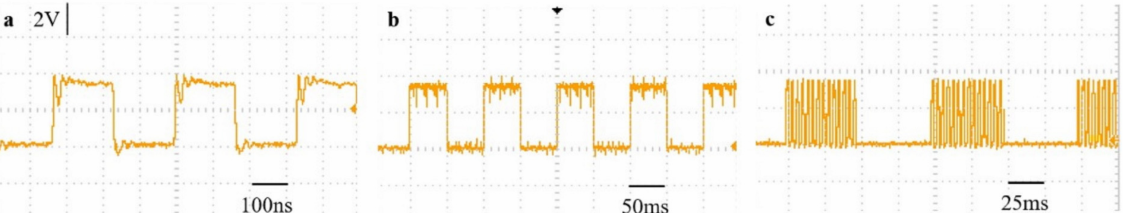
Figure 7. The modulation of the V g signal ( a ) the high-frequency carrier pulse S 2 = 3 MHz; ( b ) the low-frequency stimulation pulse S 1 = 10 Hz; ( c ) the V g signal.